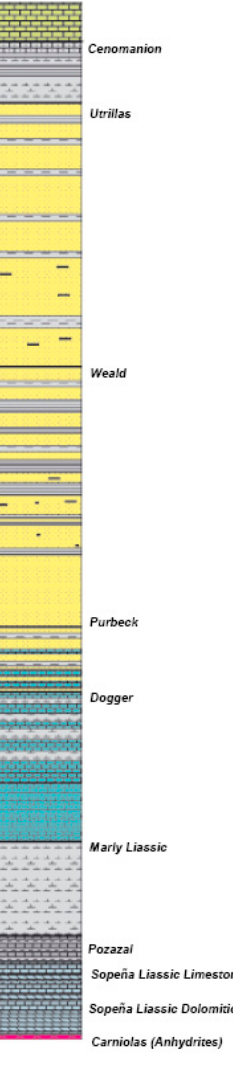
Figure 1. The lithological column of the Hontomín site (adapted from de Dios et al. 2017 [11]).